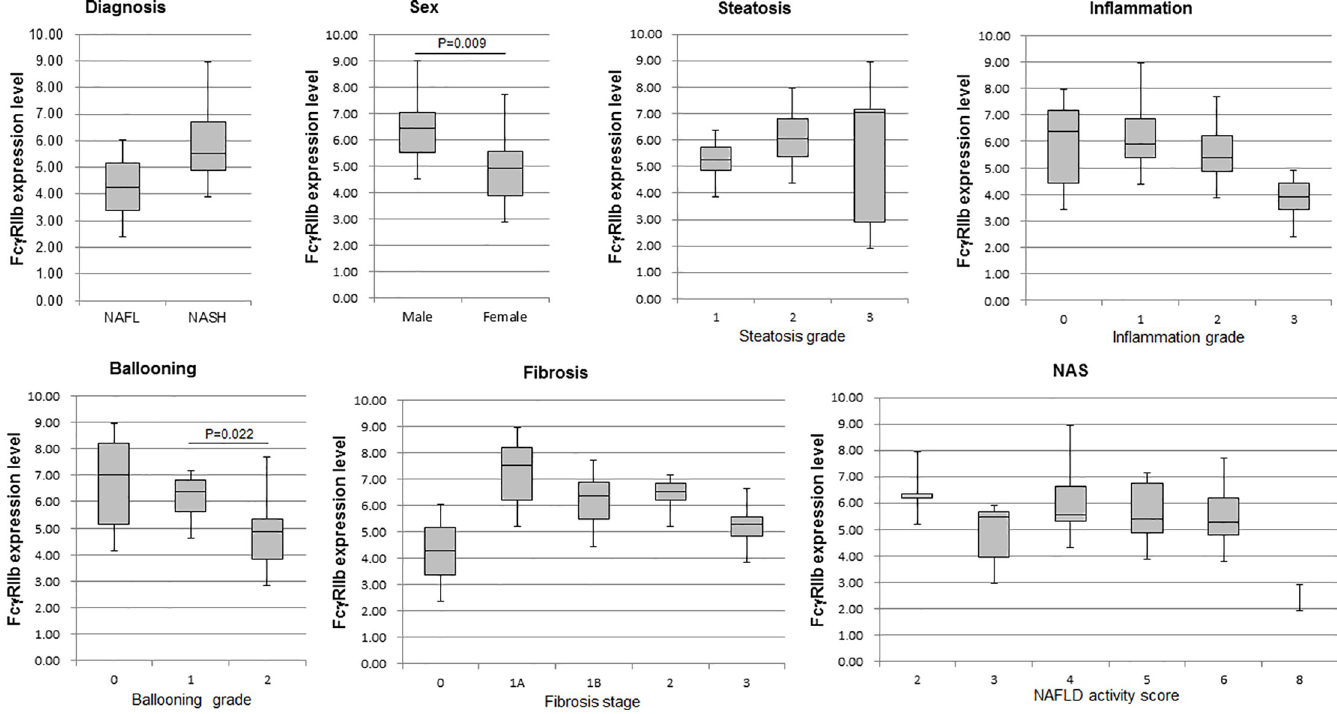
Fig 3. Comparisons of diagnosis, sex, and pathological scores. Box plots show Fc γ RIIb expression levels. Lines inside the boxes denote medians, the boxes represent the interquartile range, and whiskers extend to the minimum and maximum. The statistical differences among groups are analyzed by the Mann-Whitney or the Kruskal-Wallis test. A P-value < 0.05 was considered to be significant.